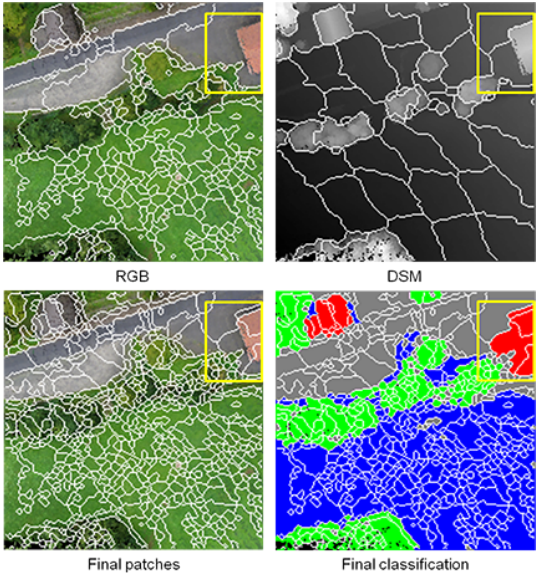
Figure 11. Classification results affected by artifacts in the data (red – buildings, gray – ground, blue – grass, and green – trees) caused by artifacts of the data points concerning color or geome- try. As shown in Figure 11 (top), the partial roof at the top-right corner contains false points on the edges, which result in a false segmentation concerning both color and DSM. Once a patch is falsely segmented crossing two classes, this error directly affects the final result.